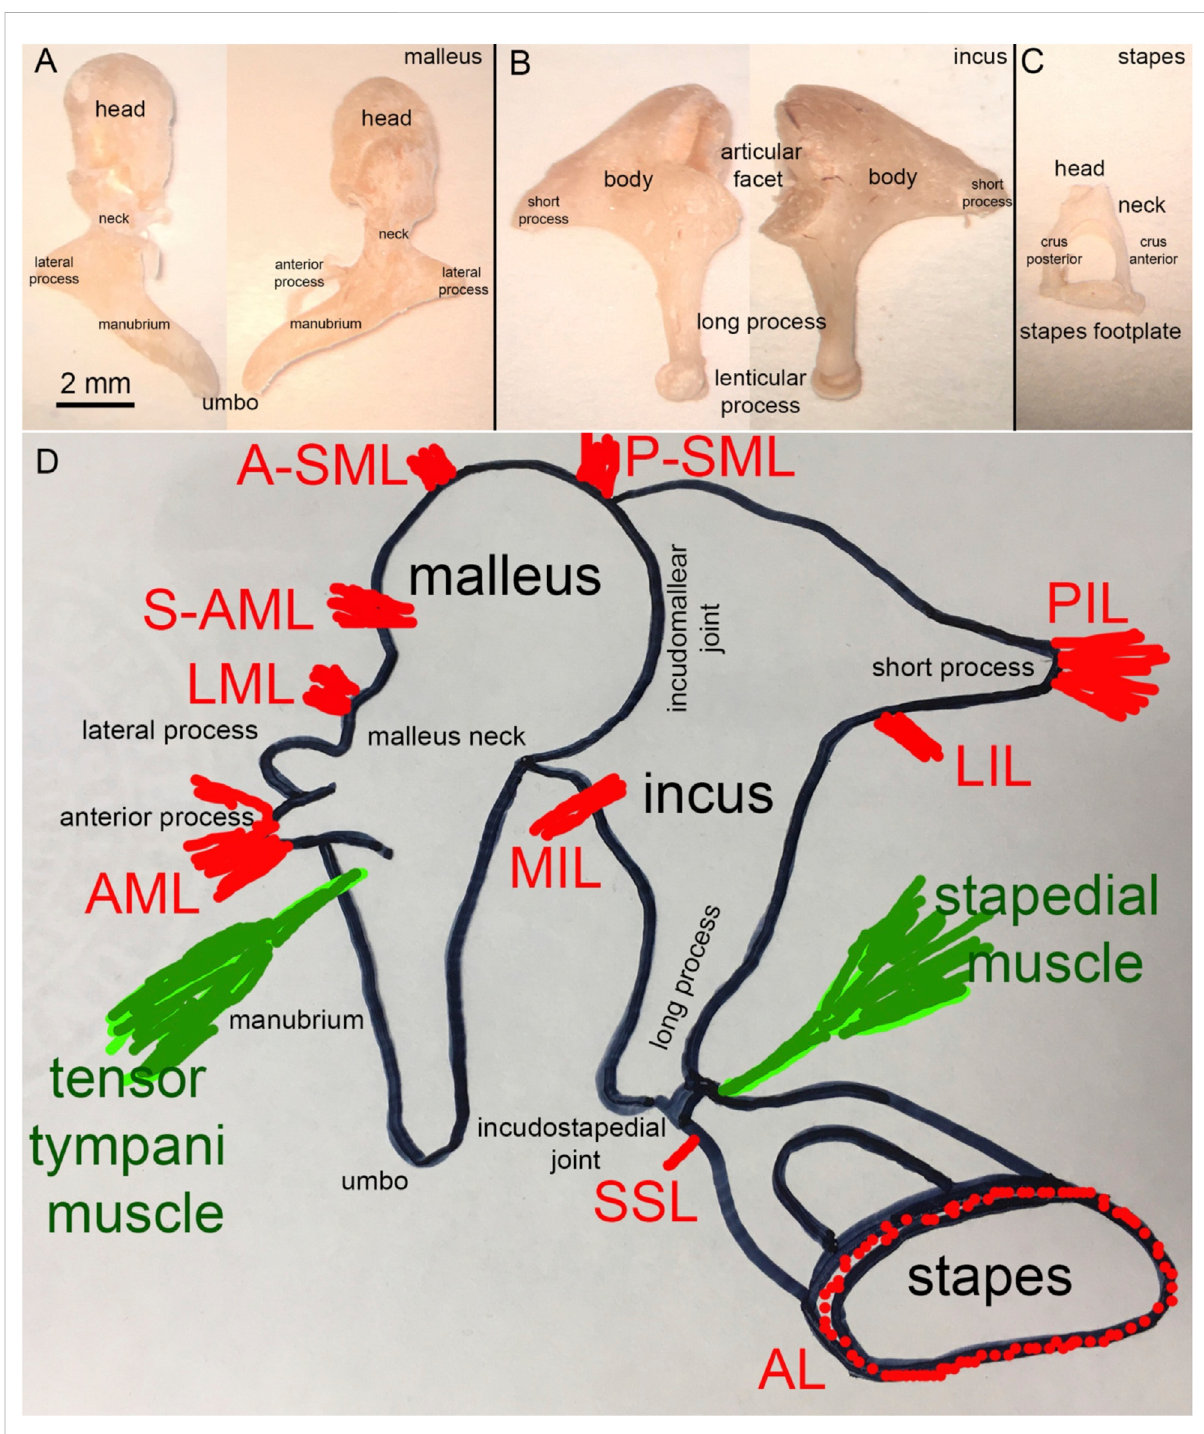
FIGURE 4 (A) Human malleus, (B) incus, and (C) stapes (D) Schematic representation of the attachment of the major middle ear